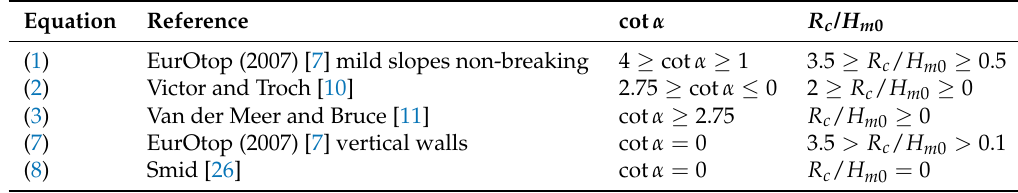
Table 4. Summary of the overtopping prediction formulae overviewed in this paper and their range of application.